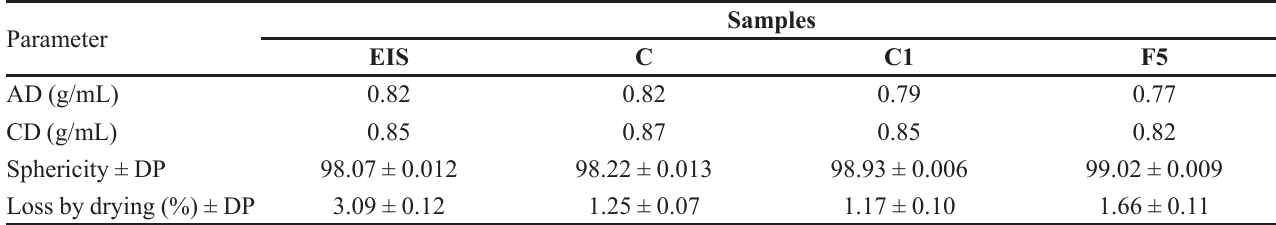
TABLE VII - Characterization analyses of pellets obtained